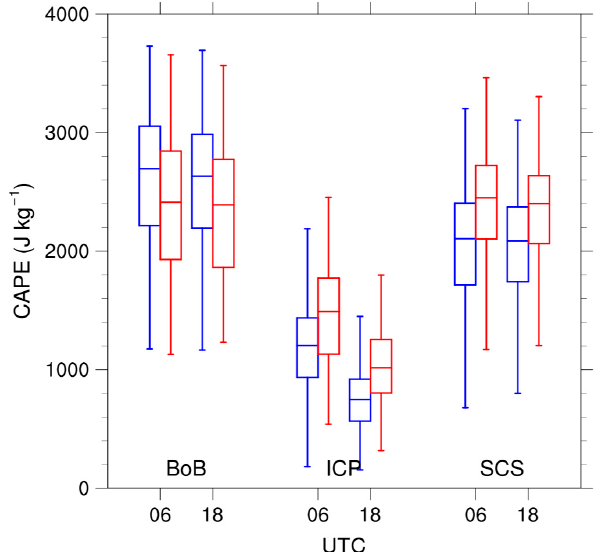
Figure 10. The box-and-whisker plots for the daily CAPE in May for BoB, ICP, and SCS. The daily CAPE is averaged over the corresponding regions. Blue and red for cold and warm years, respectively. Outliers are excluded by 1.5 interquartile ranges. Table 2. The correlation coefficients between the preceding winter (spring) ONI and some monthly atmospheric variables over the ICP region of May for three different periods: 1979–2000, 2000–2021, and 1979–2021. The correlation coefficients calculated against spring ONI are given in